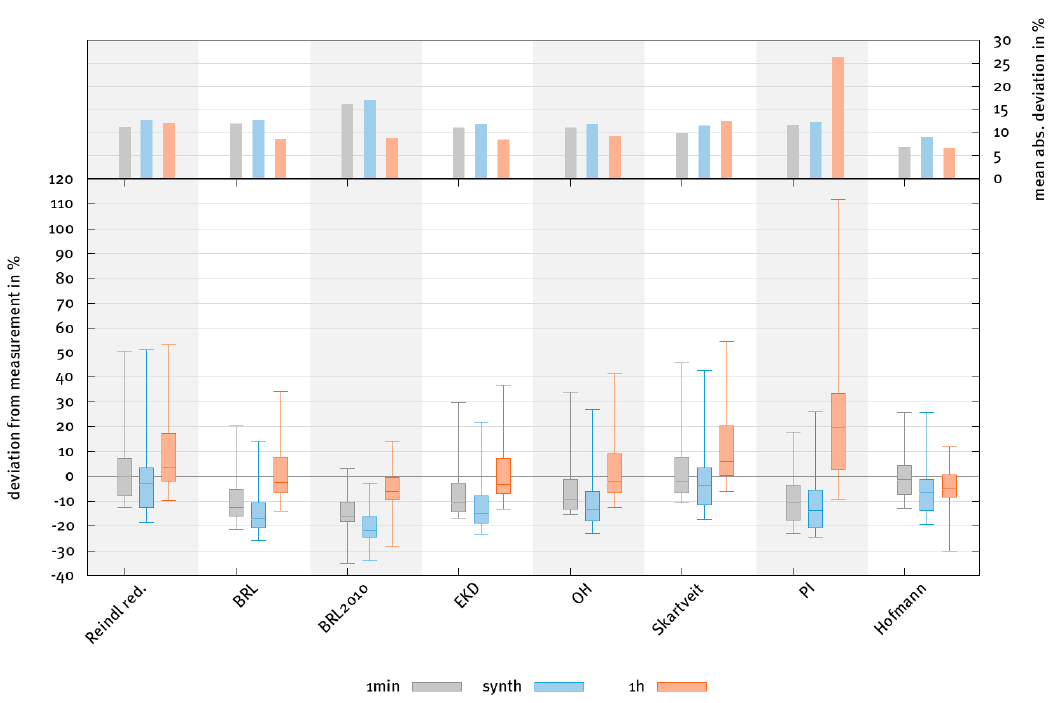
Figure 4. Deviation of the modeled annual diffuse irradiation (irradiance integrated over one year) from the measured irradiation. The bottom plot displays the deviations over all locations and model combinations grouped by the diffuse fraction model. Each box and whisker contains results from 30 simulations at different locations. The top plot displays the average over all absolute (unsigned) deviations in the boxes and whiskers at the bottom.